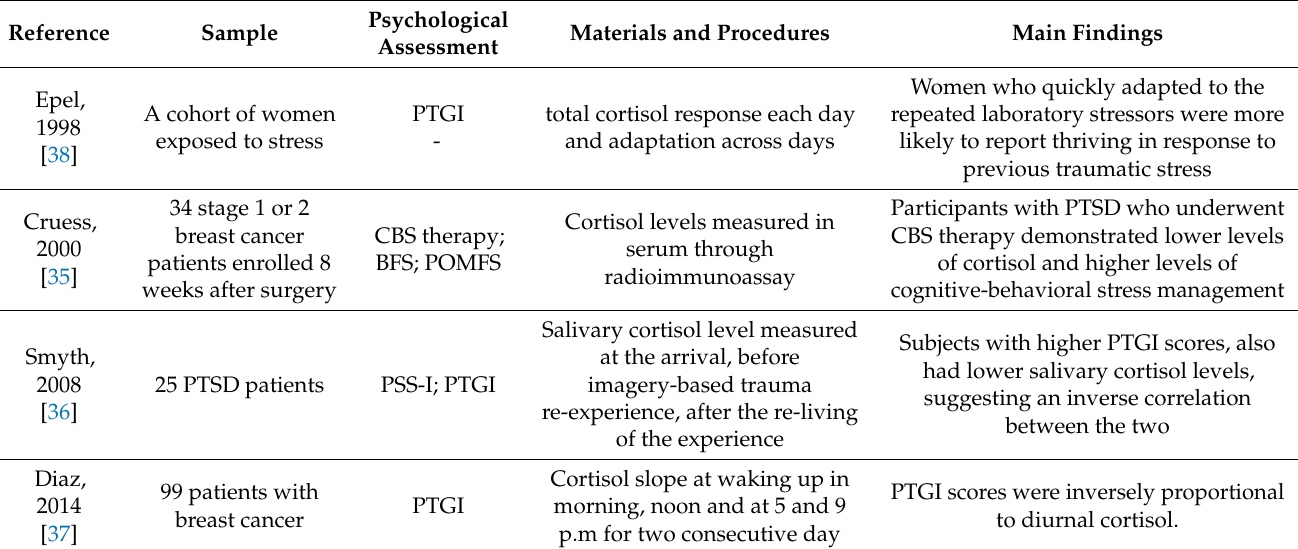
Table 2. Studies on HPA axis